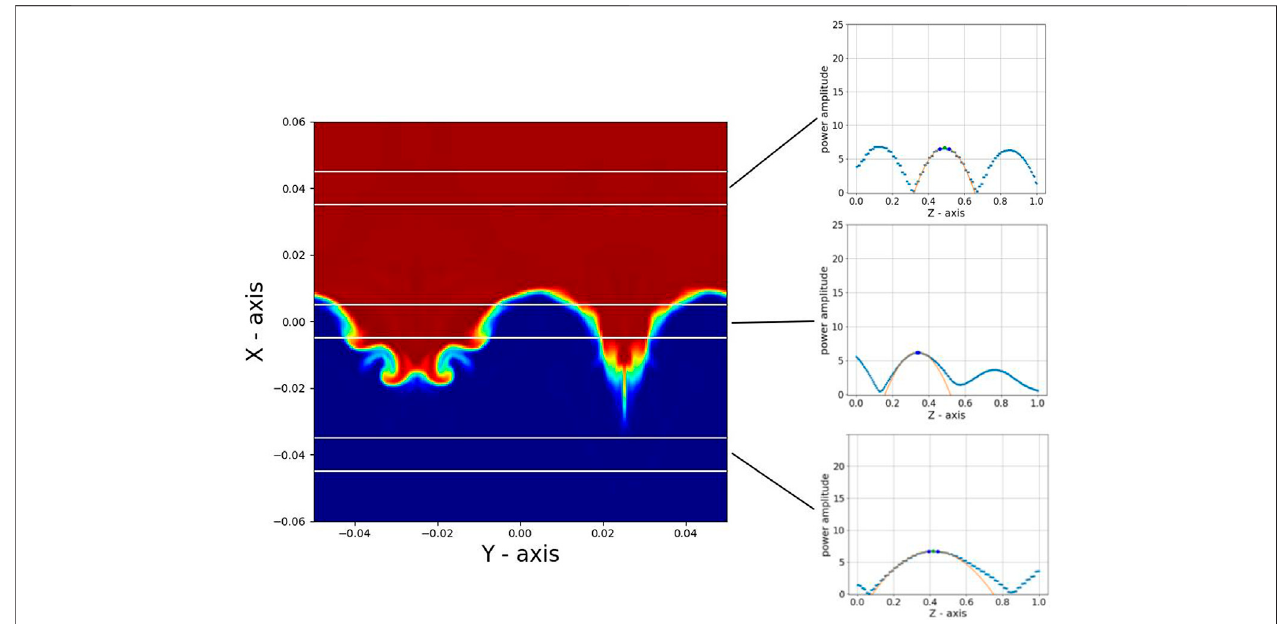
FIGURE 9 | Comparison of wave ’ s amplitude in the fundamental mode for the different regions. It shows that Alfvén waves have shorter wavelength in the upper half, compared to the surface Alfvén waves. Similarly, the lower half has a longer wavelength.